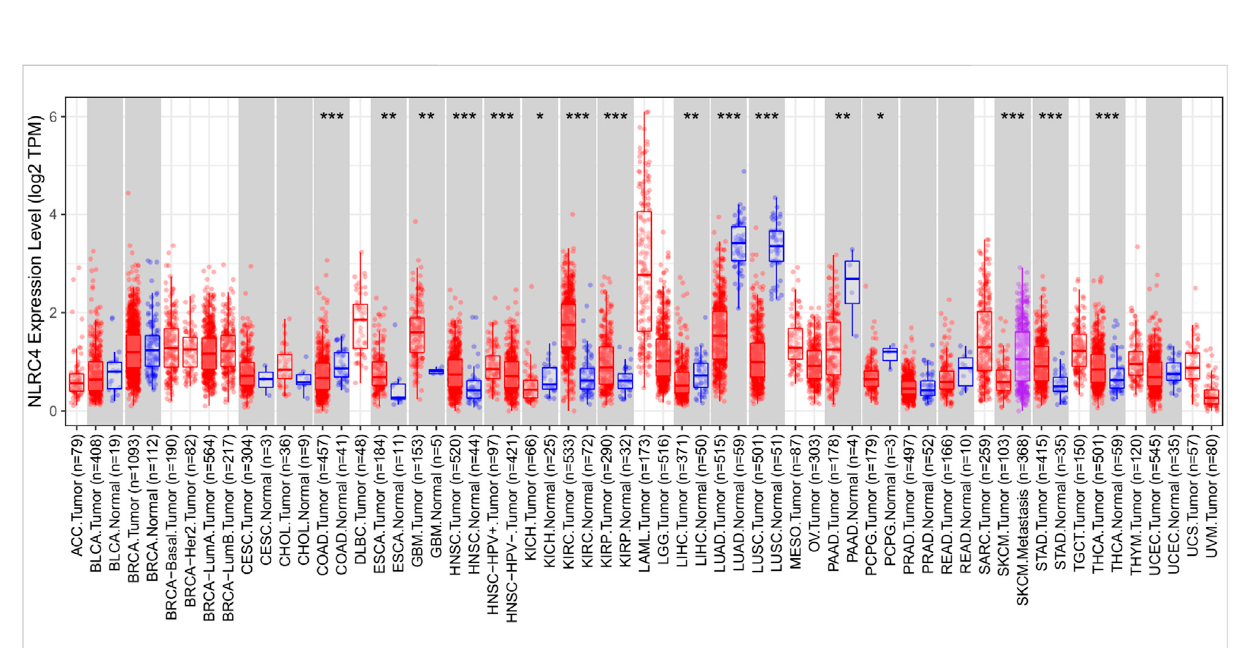
FIGURE 10 Expression of NLRC4 in pan-cancer compared with normal samples. Expression of NLRC4 was signi fi cantly lower in LUAD samples than in normal samples.